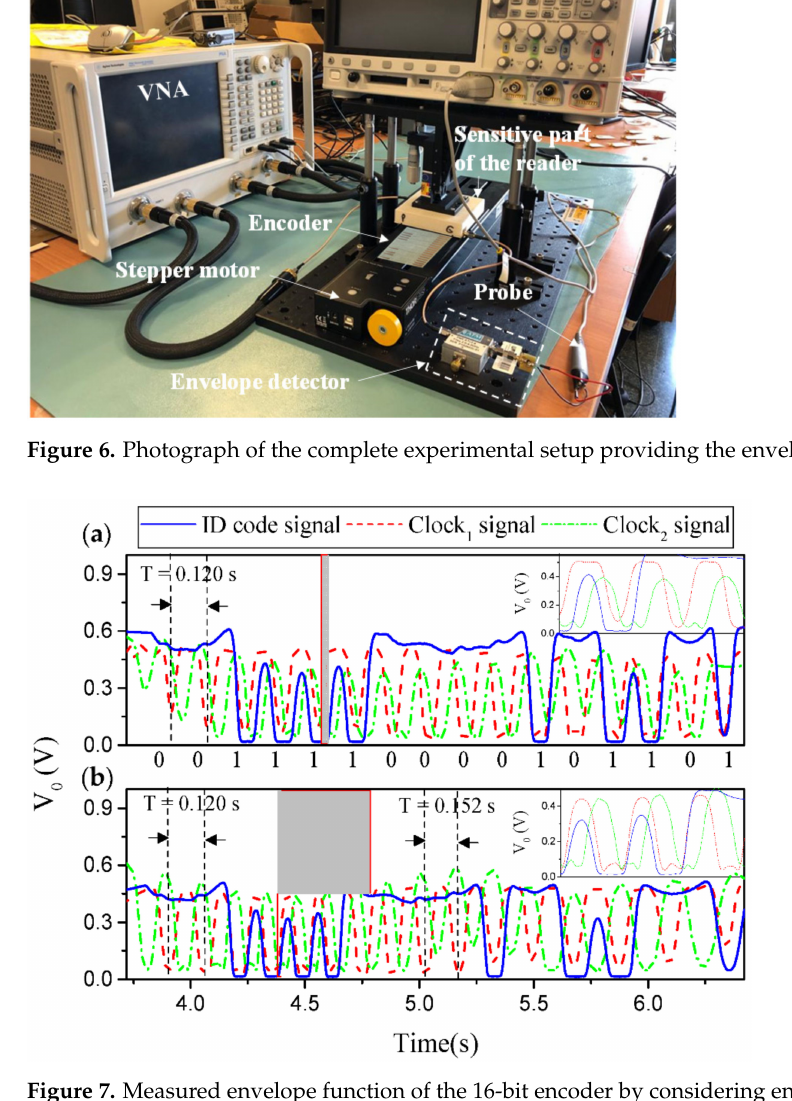
Figure 7. Measured envelope function of the 16-bit encoder by considering encoder motion with ( a ) constant velocity and ( b ) constant acceleration. The ID code is indicated. The estimated air gap in the measurements is 0.2 mm. Reprinted with permission from [32]. Copyright 2021